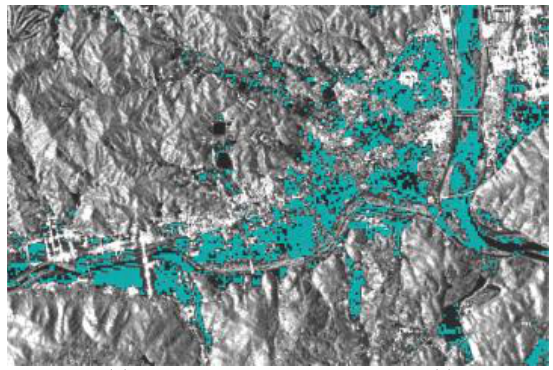
Figure 7. The expected flooding areas in Okayama Pref., Japan estimated by PALSAR-2 images acquired after (July 8, 2018) and before (multi-temporal images) colored by